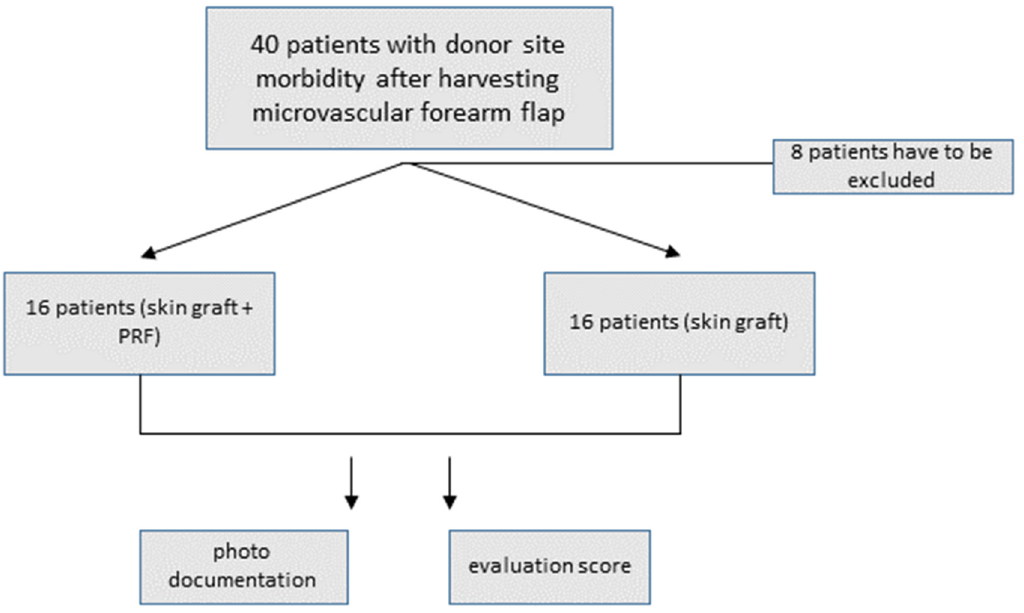
Figure 1. Flowchart depicting patient selection and study design.